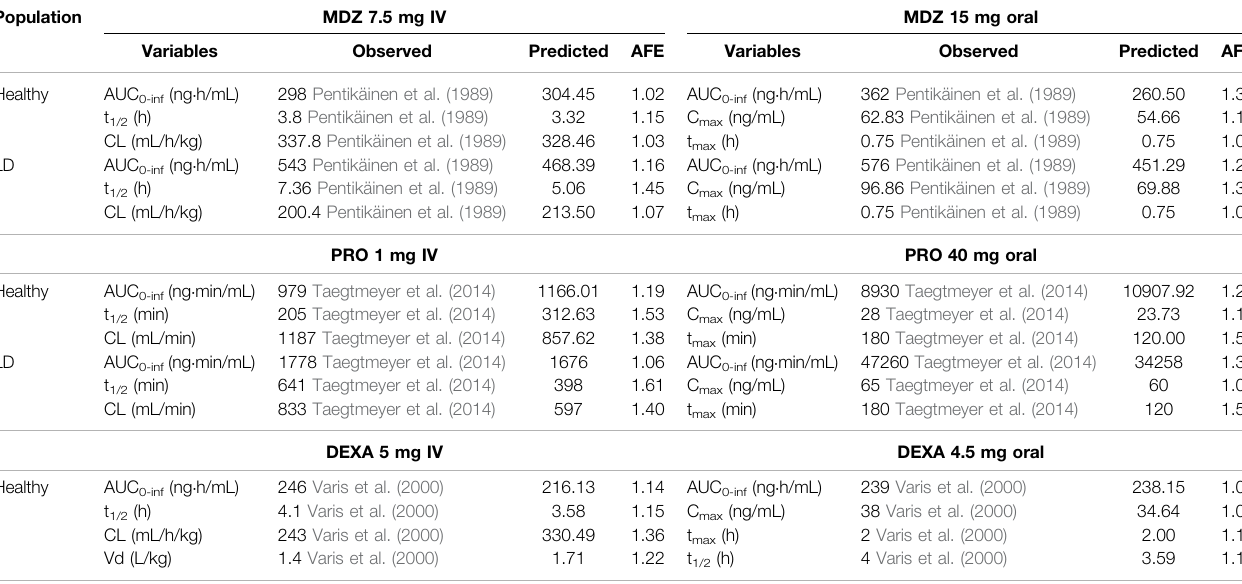
Data are presented as the mean as described in section methods-model quali fi cation. MDZ, midazolam; PRO, propranolol; DEXA, dexamethasone. AUC 0-inf , area under the plasma concentration-time curve over a dosing interval. C max maximum plasma concentration. t 1/2, half-life time. CL, clearance. t max, time to maximum plasma concentration. Vd, volume of distribution. LD, liver dysfunction; AFE, average fold